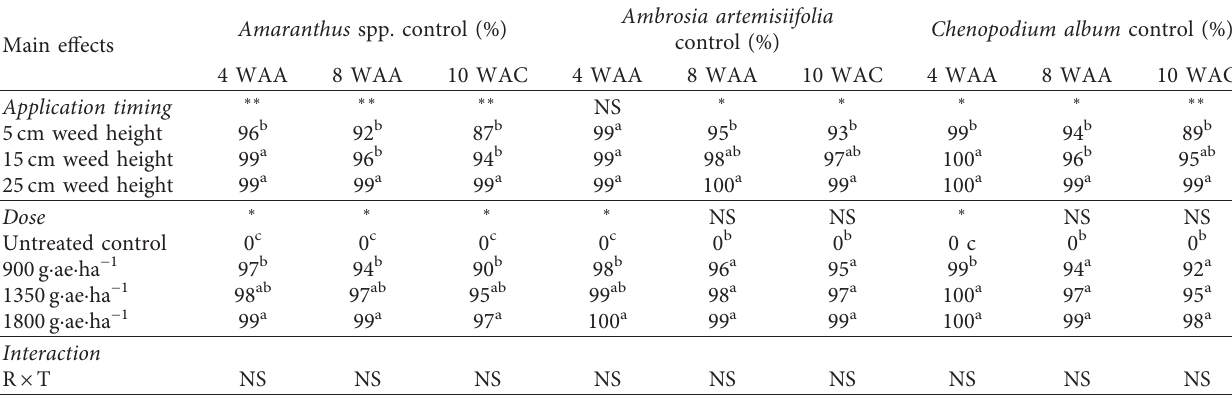
Table 3: Significance of main effects and interaction for percent visible control of Amaranthus spp., Ambrosia artemisiifolia , and Che- nopodium album in soybean treated with glyphosate/dicamba at various POST timings at four Ridgetown, ON, sites (2016–2018) and two Exeter, ON, sites (2017-2018).